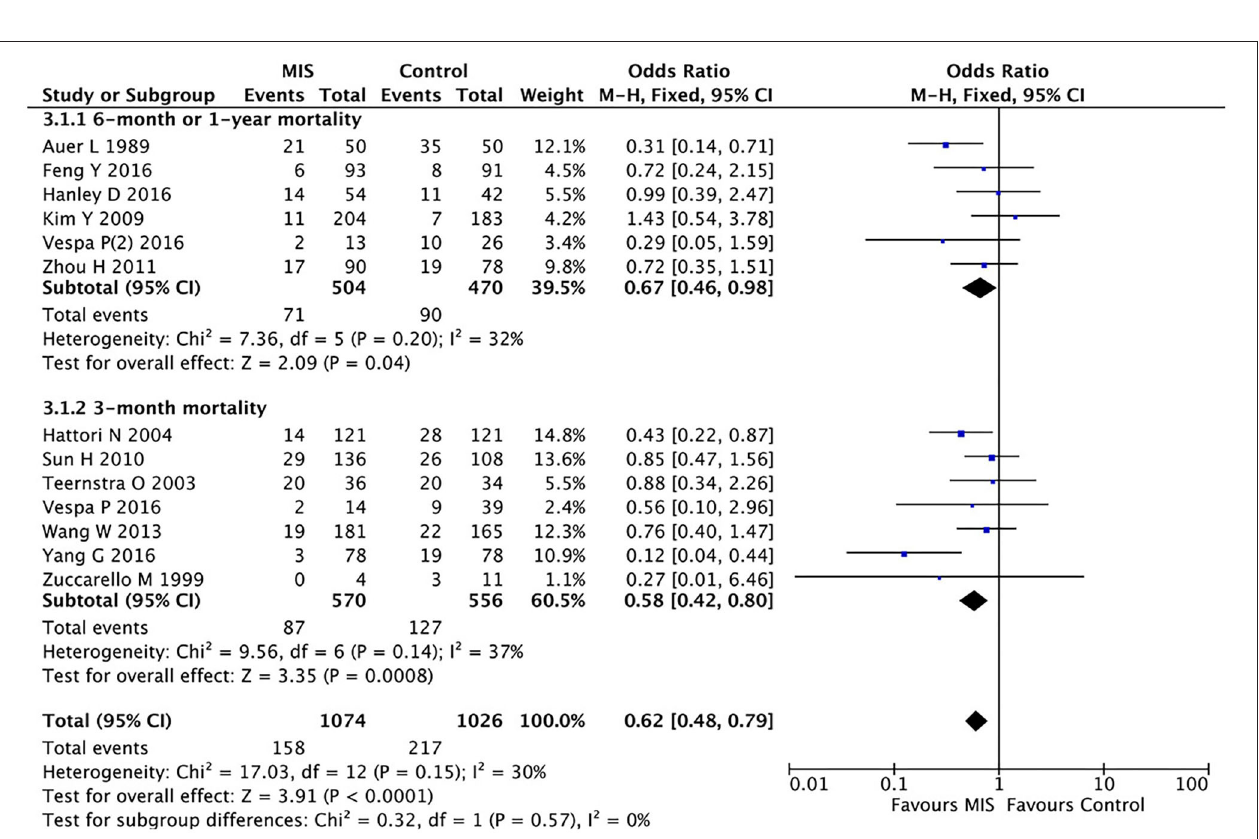
Frontiers in Neurology | www.frontiersin.org 6 January 2022 | Volume 12 | Article